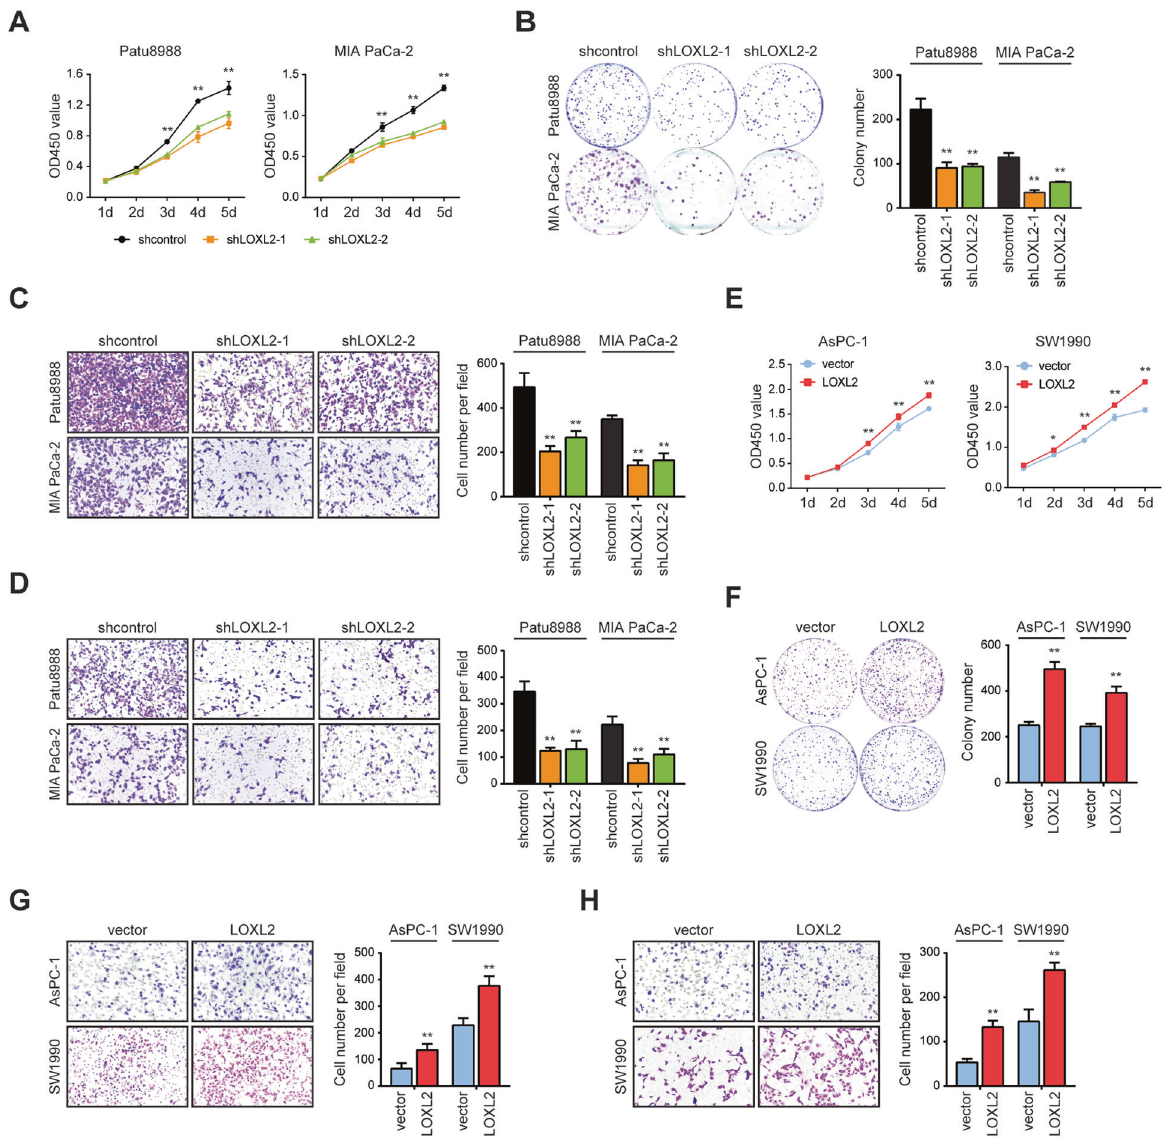
Fig. 3 LOXL2 promotes PDAC cell proliferation, migration, and invasion in vitro. A CCK-8 assay of LOXL2 knockdown and control cells. B Colony formation assay of LOXL2 knockdown and control cells. C Transwell migration assay of LOXL2 knockdown and control cells. D Transwell invasion assay of LOXL2 knockdown and control cells. E CCK-8 assay of LOXL2-overexpressing and vector control cells. F Colony formation assay of LOXL2-overexpressing and vector control cells. G Transwell migration assay of LOXL2-overexpressing and vector control cells. H Transwell invasion assay of LOXL2-overexpressing and vector control cells. * p < 0.05, ** p <